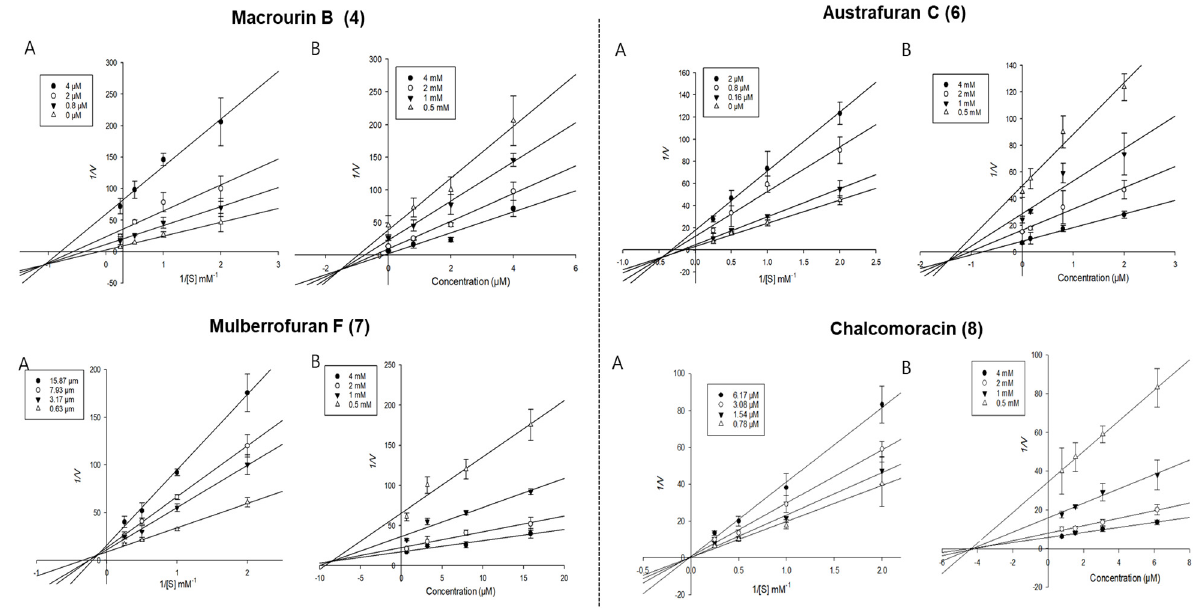
Figure 4. Lineweaver-Burk plots ( A ) and Dixon plots ( B ) of PTP1B inhibition by compounds 4 and 6 – 8 .